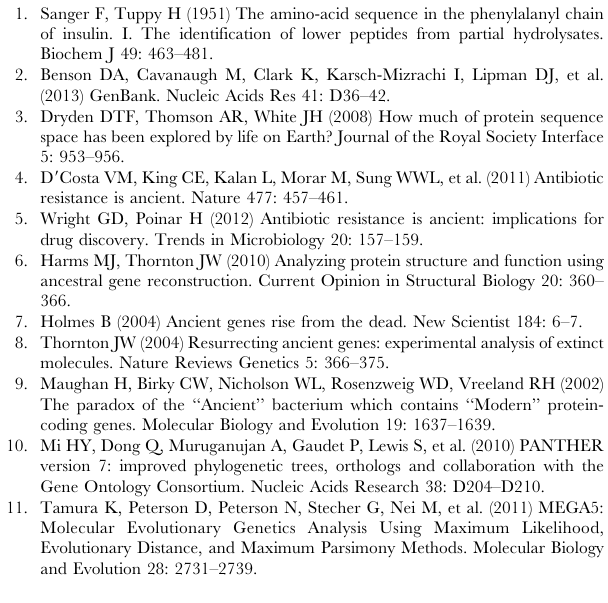
Information S1 Table S1 . Protein names, gene identifers and mutation profiles of all IMP sequence used in the construction of phylogenetic trees and protein networks. Gene identifiers were taken from (http://www.lahey.org) where available. Table S2 . Mutations shared by all variants of the respective network in comparison to the reference sequence IMP-1. Table S3 . Triplets of IMP variants with predicted missing variant to complement the triplet to a quartet. Table S4 . Pairs of IMP variants which differ by 2 mutations with no know intermediary variants. Intermediary variants for possible pathways were predicted. Table S5 . Predicted S262G and V67F variants. Figure S1 . The distance matrix and a network representation of a triplet of sequences consisting of a wild type and two single mutants thereof (mutant 1 and mutant 2). Figure S2 . The distance matrix of a quartet of sequences consisting of a wild type, two single mutants thereof (mutants1 and 2), and the respective double mutant. Figure S3 . Left: Network representation of a quartet of sequences consisting of a wild type, two single mutants thereof (mutants1 and 2), and the respective double mutant (derived from the distance matrix in Figure S2). Right: the four sequences cannot be represented by a binary tree assuming additivity of distances. Figure S4 . From a network of four variants of known sequence (black), three variants (red) can be predicted that are expected to be functional and to exist in the biosphere. Figure S5 . From the network constructed in Figure S4, four further mutants (green) can be predicted that are expected to be functional and to exist in the